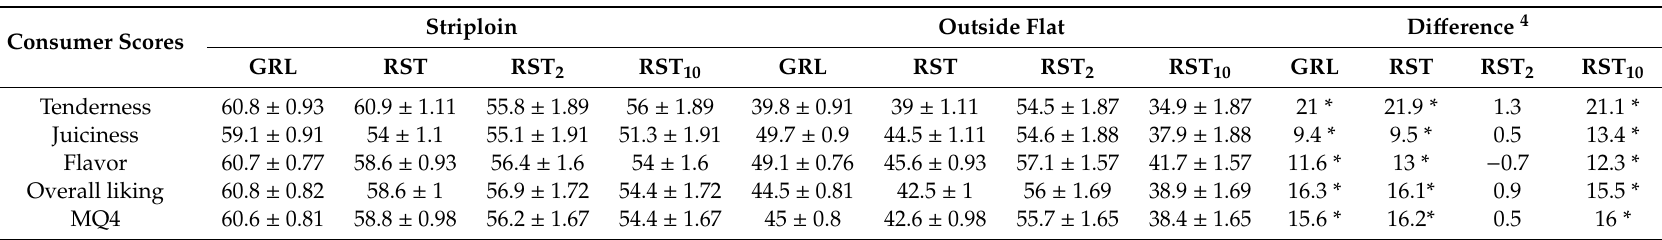
Table 4. Estimated marginal means ( ± 95% confidence interval), and di ff erence between striploins ( M. longissimus lumborum ) and outside flats ( M. biceps femoris ) scores for tenderness, juiciness, flavor, overall liking, and eating quality (MQ4) served as grill (GRL), hot roast (RST), cold roast as a 2 mm slice (RST 2 ) and cold roast as a 10 mm slice (RST 10 ) for tenderness, juiciness, flavor, overall liking, and eating quality (MQ4) 1,2,3